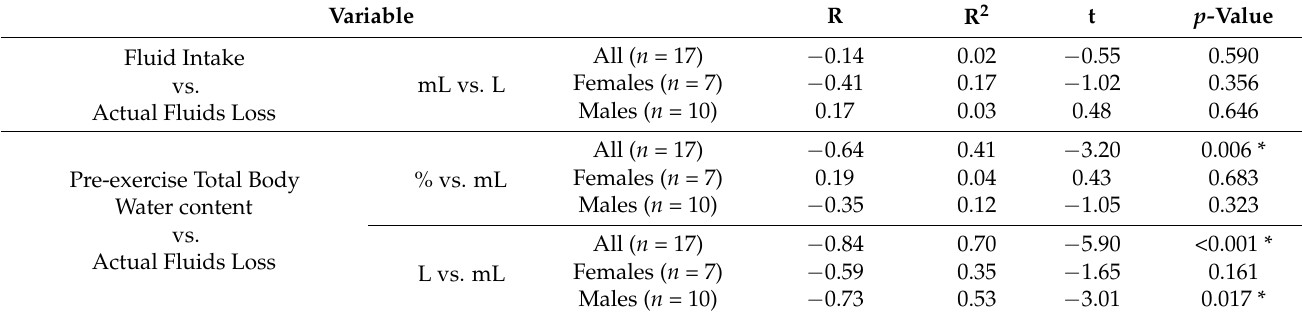
Table 3. Correlation between selected primary indices in the whole group, female and